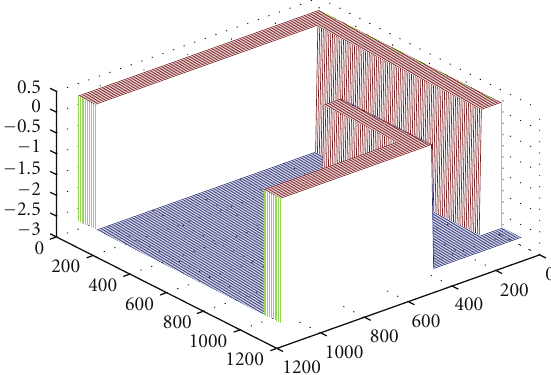
started its operation on April 10, 1995. The plant is owned and operated by the national electric company owned by the Mexican government (see Figure 10).